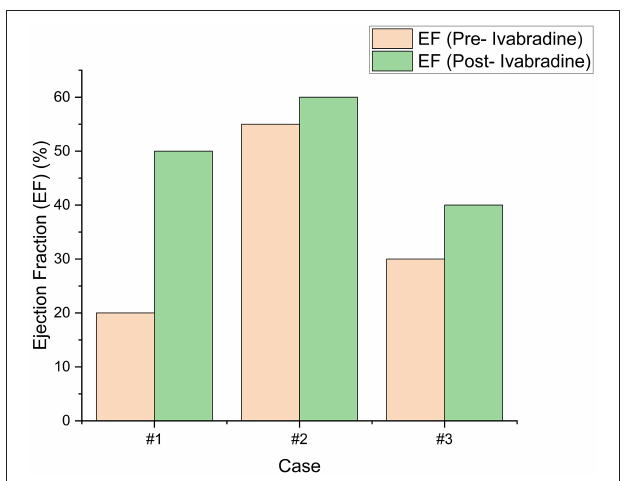
FIGURE 6 | The left ventricular ejection fraction (LVEF) of our patients pre- and post-ivabradine. A significant improvement of 30% was achieved in our first patient. On the contrary, a modest improvement (of 10%) in LVEF was noted in patient #3. To note, our second patient had no LV systolic dysfunction prior to ivabradine intake. His LVEF remained within normal thereafter and improved by around